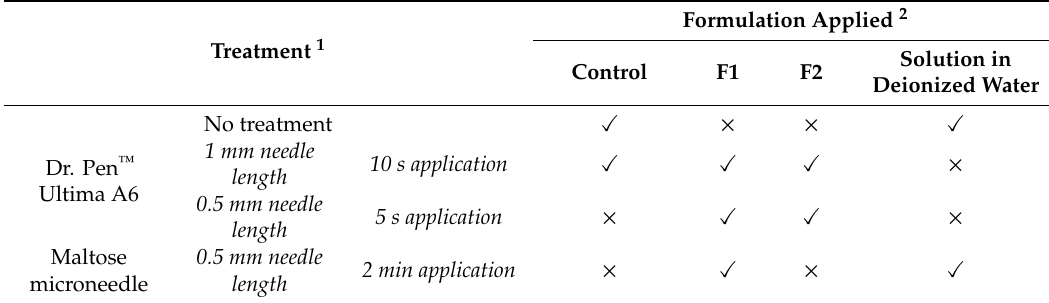
Table 2. Study design for in vitro permeation